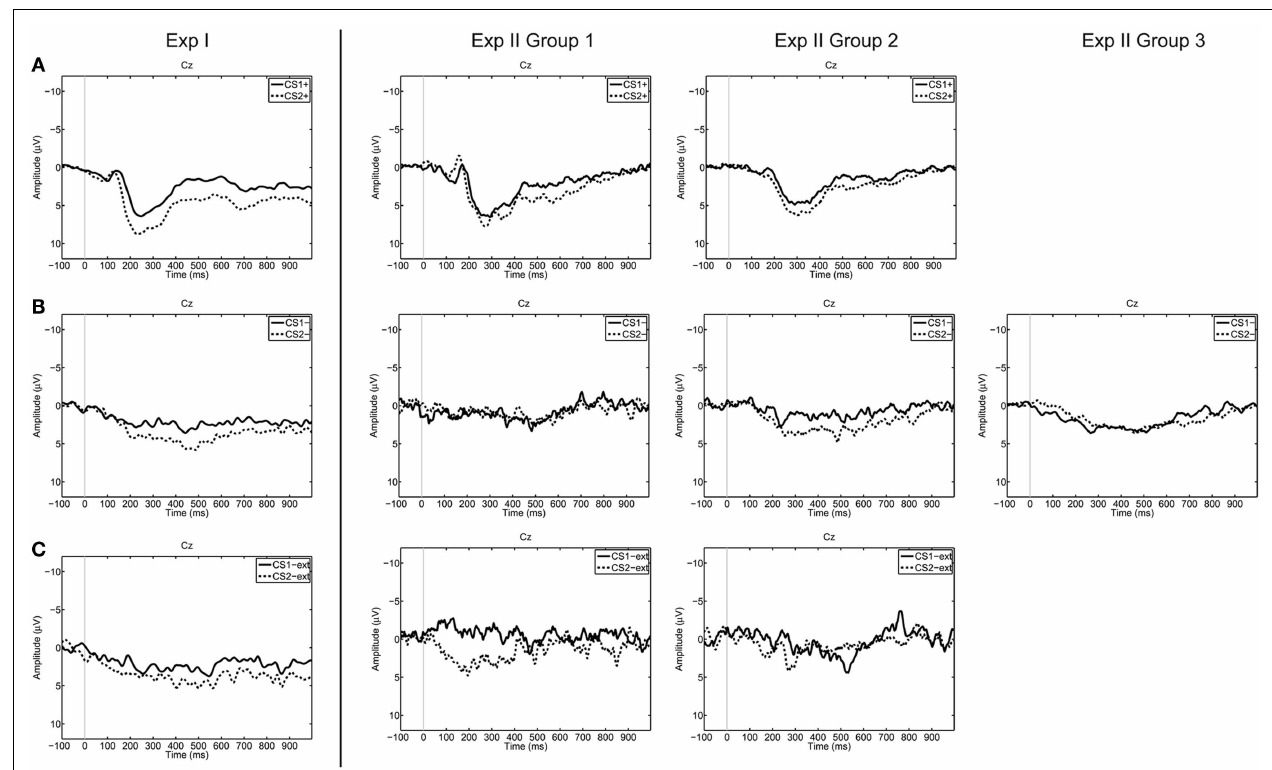
the solid lines represent trials corresponding to “yes” thinking (CS1).The grand average was calculated over all available trials for each trial type. From left to right Exp I, Exp II Group 1, Group 2, and Group